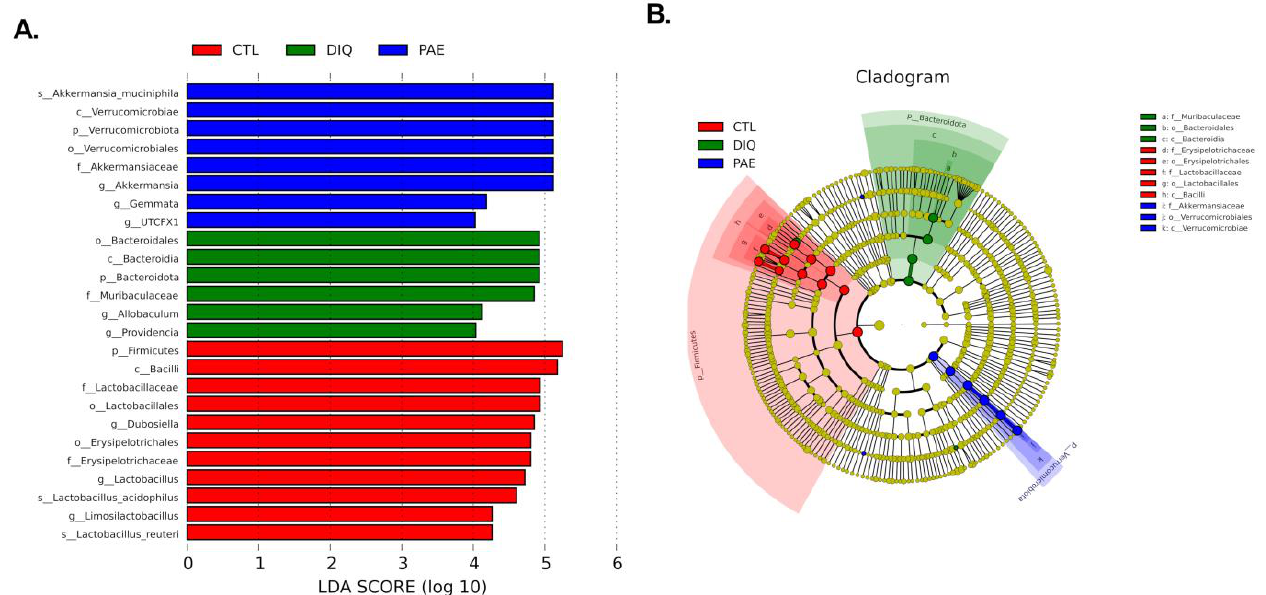
Figure 7. The analysis of LEfSe and LDA based on OTUs characterized the microbiomes of cecum in mice: ( A ) LDA score histogram shows taxonomic biomarkers (the LDA score (log10) > 4); ( B ) LEfSe evolutionary cladogram shows the phylogenetic distribution of the cecal microbe. PAE, PAE-100 (100 mg/kg) group.